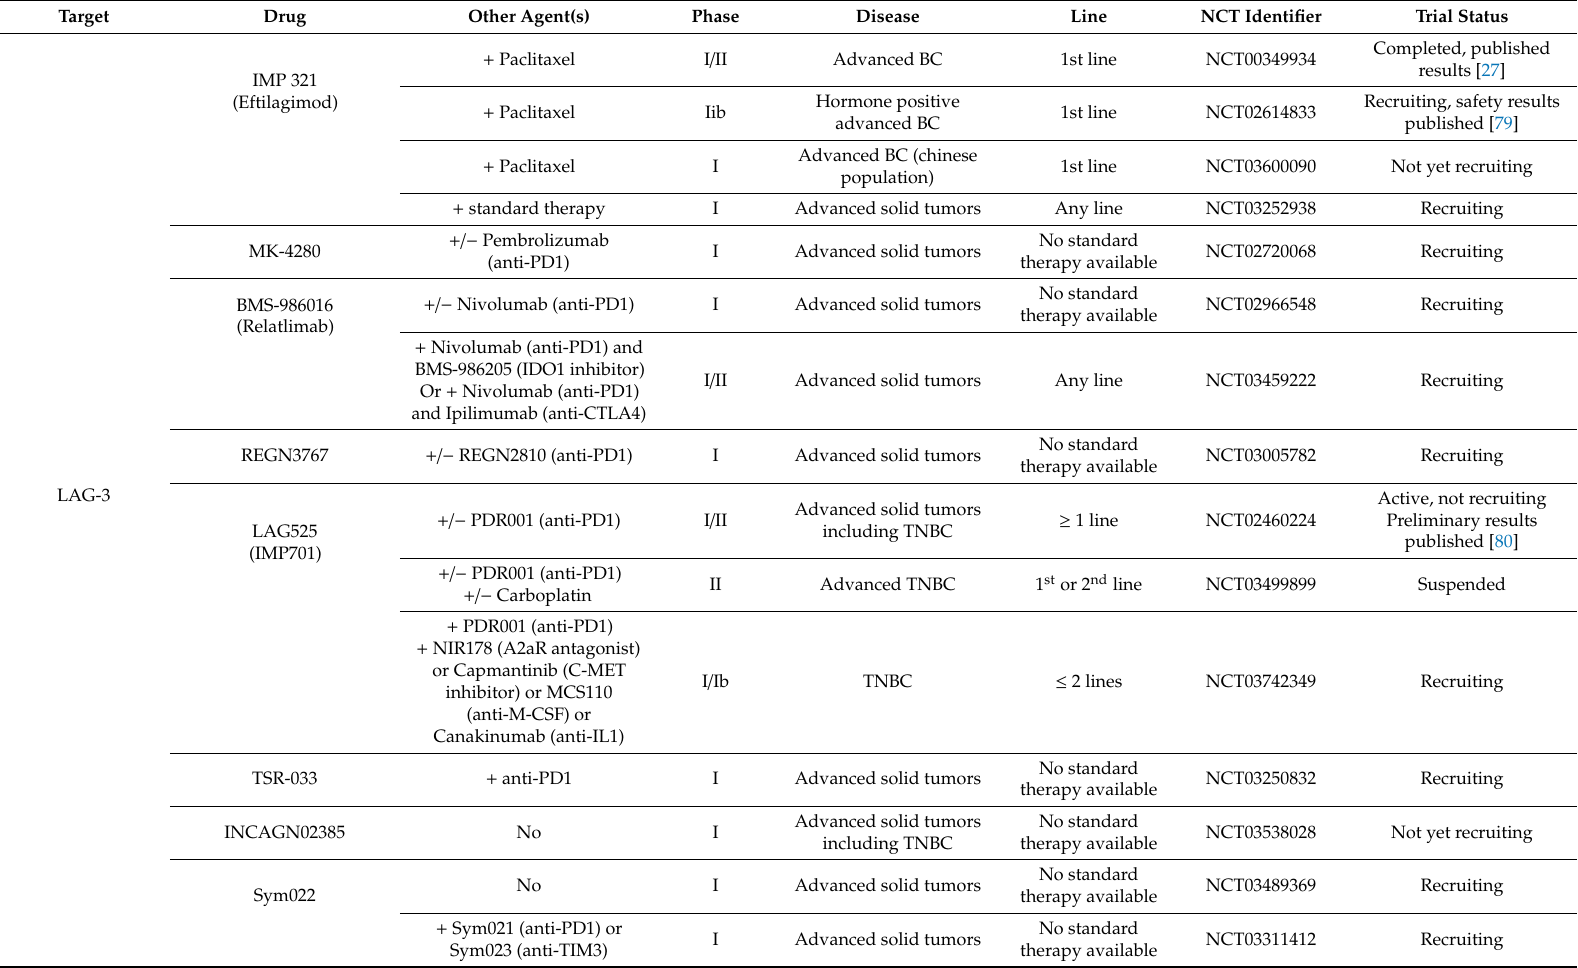
Table 2. Ongoing clinical trials potentially including breast cancer patients for targeting immune-related markers predominantly expressed on